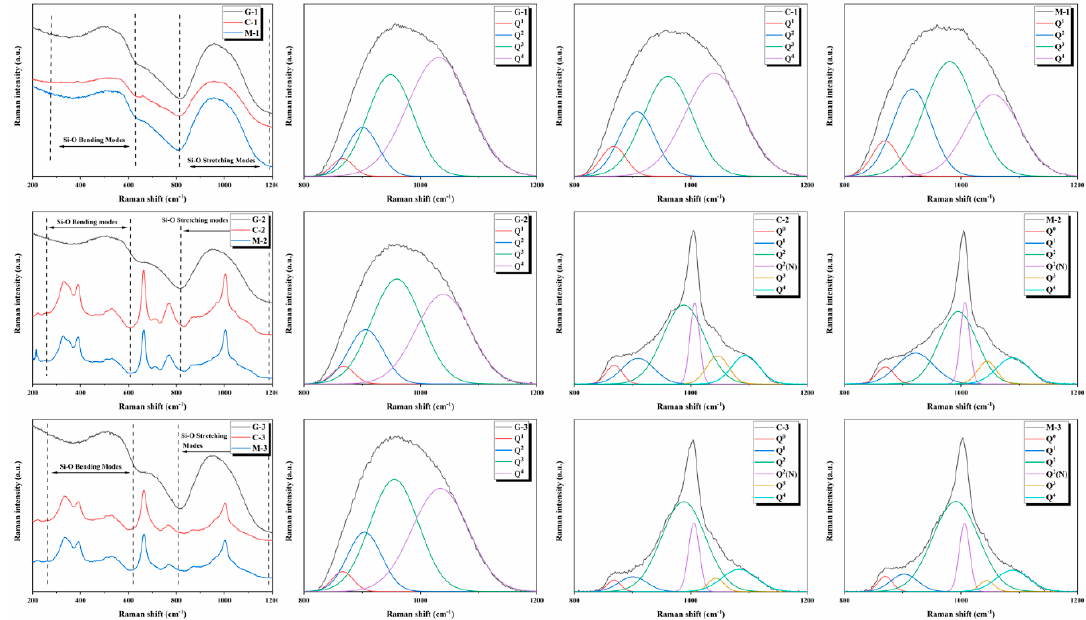
Figure 5. Raman spectra of annealed glass and crystallized glass-ceramics produced by conventional heating and microwave heating.